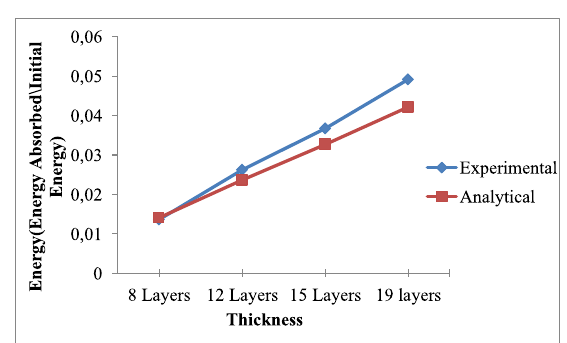
Figure 22. Comparison chart for variation in dimensionless parame- terwiththicknessofplatesfor0/90/30/-60lay-upobtained analytically and experimentally.